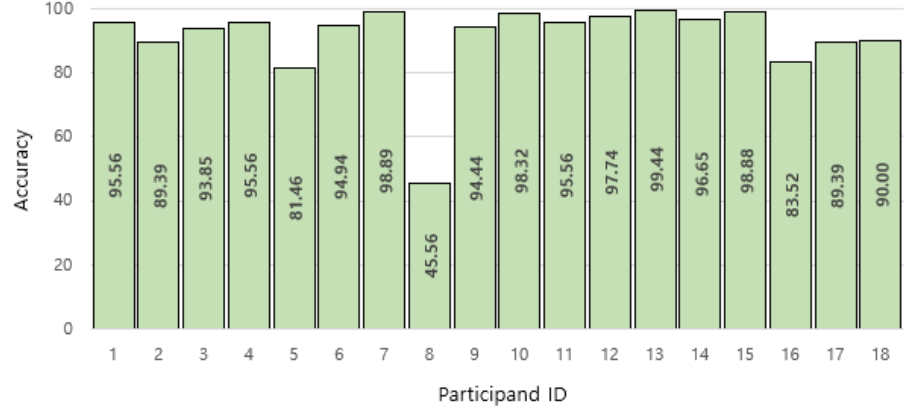
Figure 14. Accuracies according to the